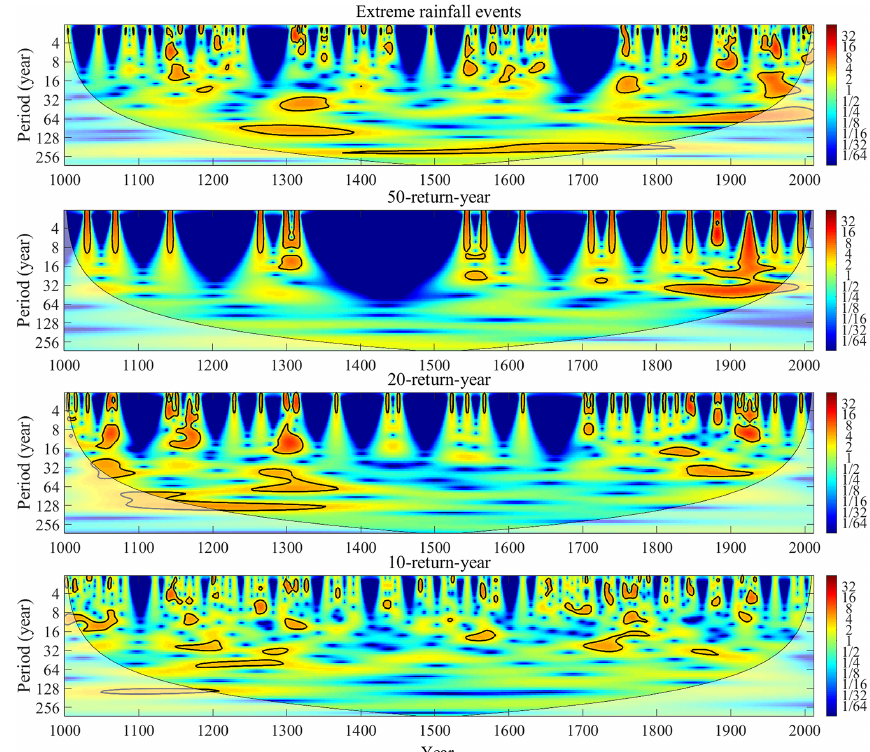
Figure 9. Wavelet analysis for new time-series datasets generated by the thresholding process for estimated annual rainfall and peak discharge over the past 1000 years in the Yalu River based on the level of extreme rainfall events and design